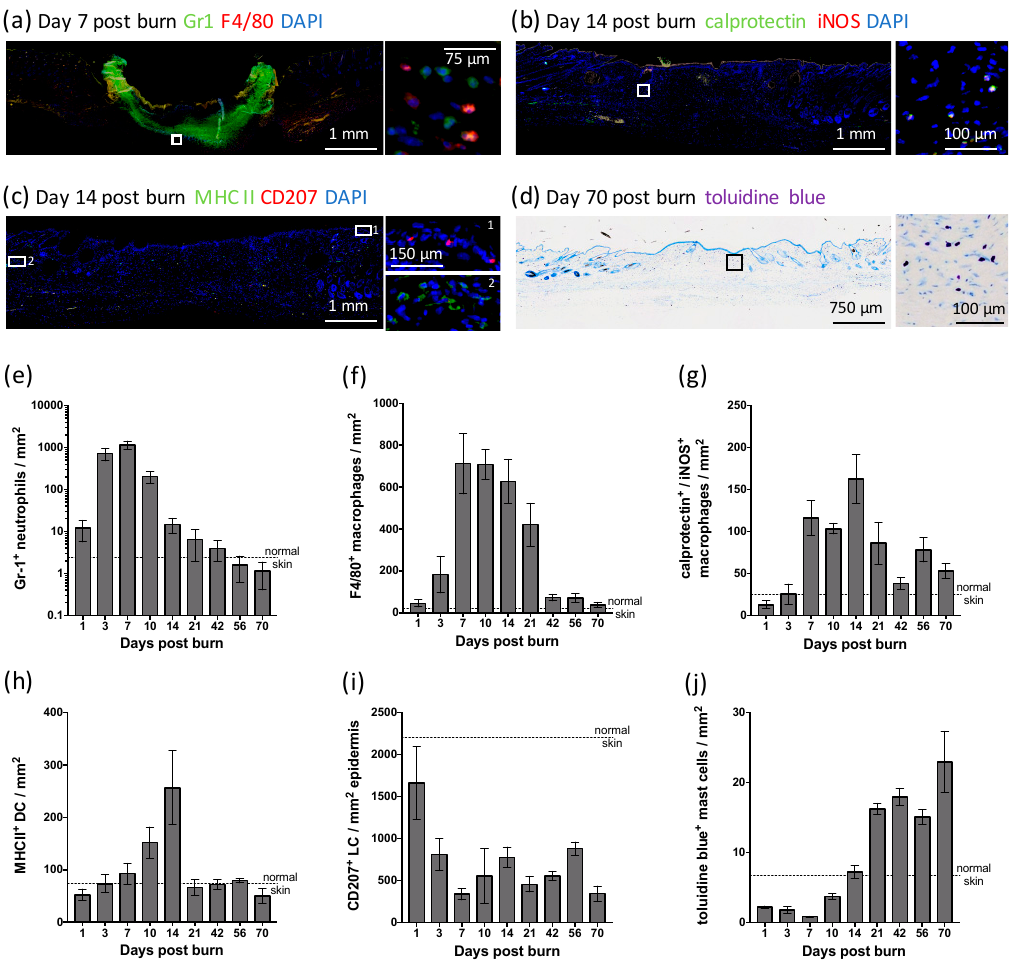
Figure 4. Profile of inflammatory cell populations during healing and scarring of heated rod burns. Images of skin sections stained with 4 ′ ,6-diamidino-2-phenylindole (DAPI) and antibodies against ( a ) Gr-1 and F4/80, ( b ) calprotectin and iNOS, ( c ) MHC II and CD207, or with ( d ) toluidine blue at the indicated day post thermal burn. Cell-specific staining is shown at higher magnification in the right panel. Scale is as indicated. Changes in the number of ( e ) Gr-1 + neutrophils, ( f ) F4/80 + macrophages, ( g ) calprotectin+ and iNOS + macrophages, ( h ) MHC II + DC, ( i ) CD207 + LC, and ( j ) toluidine blue + mast cells within the burn/scar over time are expressed relative to area. Values for normal skin are as indicated. Data represents the mean ± SEM, n = 6.